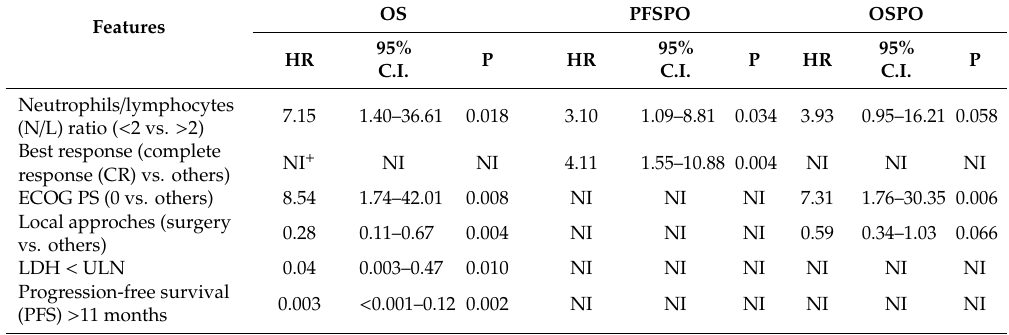
Table 2. Multivariable analysis of clinical and biological features that correlate with OS, PFSPO, and